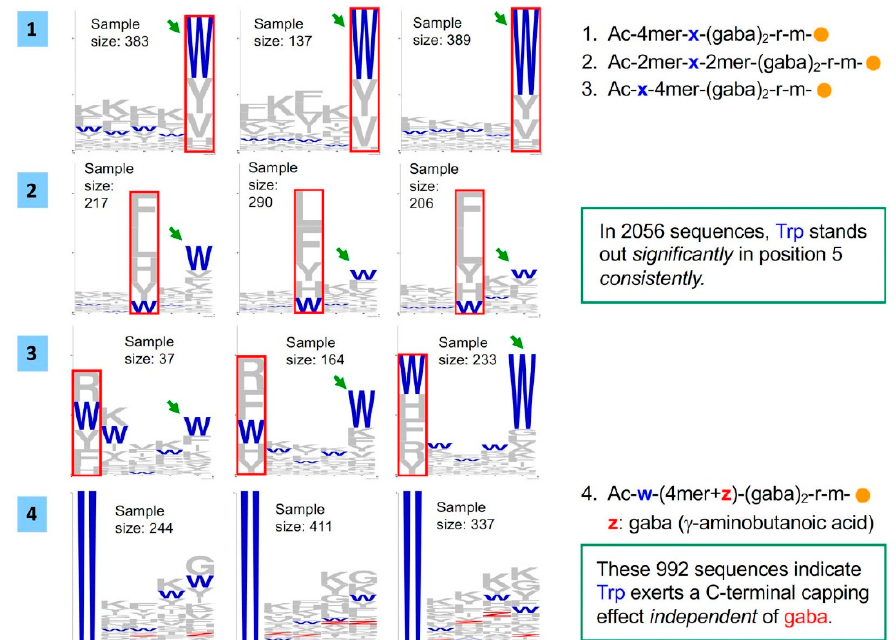
Figure 3. Summary of the screening results of the three His-centric focused libraries against C-peptide (panels 1–3). The twin blue bars in positions 5 (row 1), 3 (row 2), and 1 (row 3) correspond to His. The results of row 1 indicate that it is favourable for Trp to be in positions 1–3 when His is in position 5. The results of row 2 indicate that it is favourable for Lys to be in positions 4 and 5 when His is in position 3. The results of row 3 indicate that it is strongly favourable for Trp to be in positions 5 when His is in position 1.